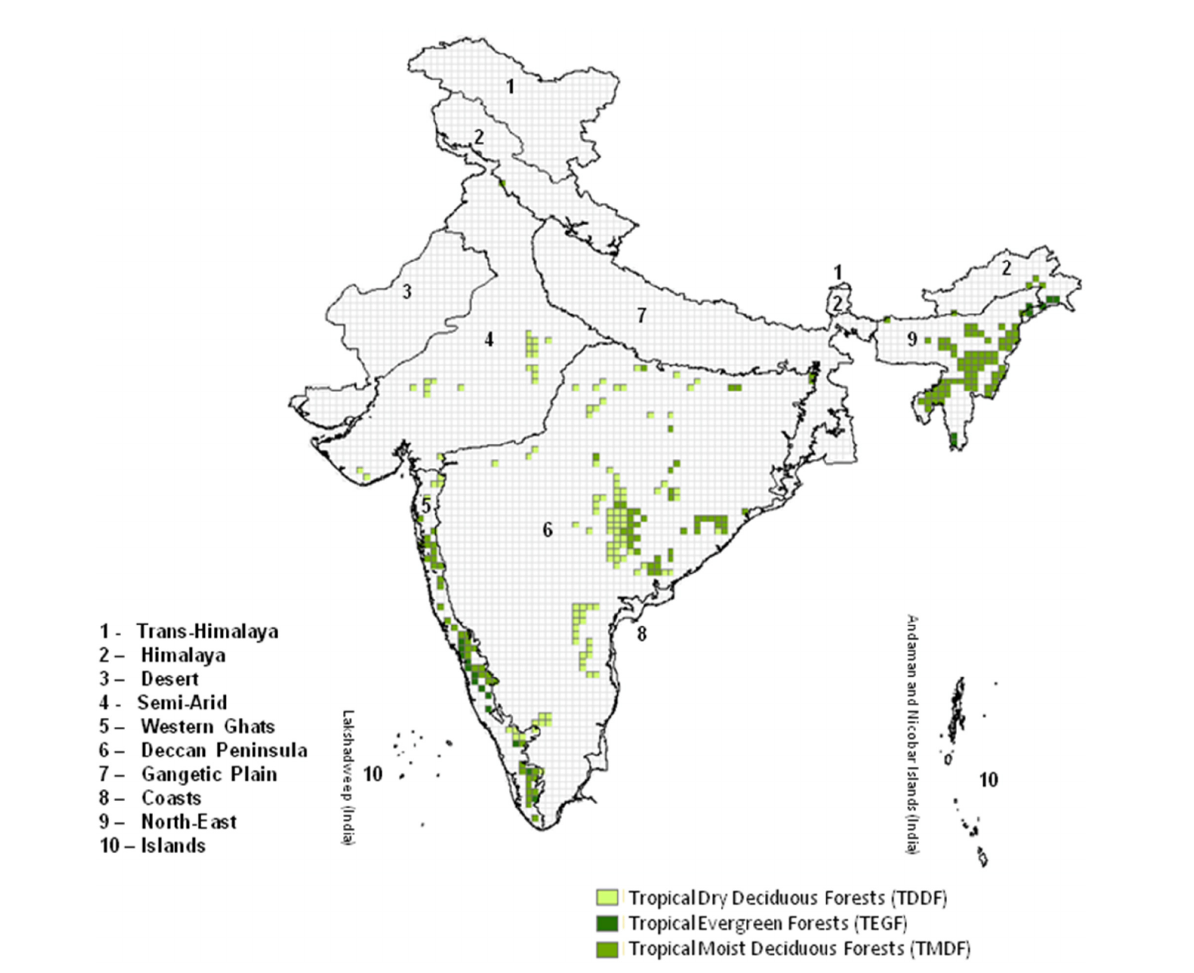
FIGURE1 Study area showing different forest types (25 km grid) overlaid on the Biogeographic zones of India (Rodgers and Panwar, 1988; Rodgers et al., 2000).